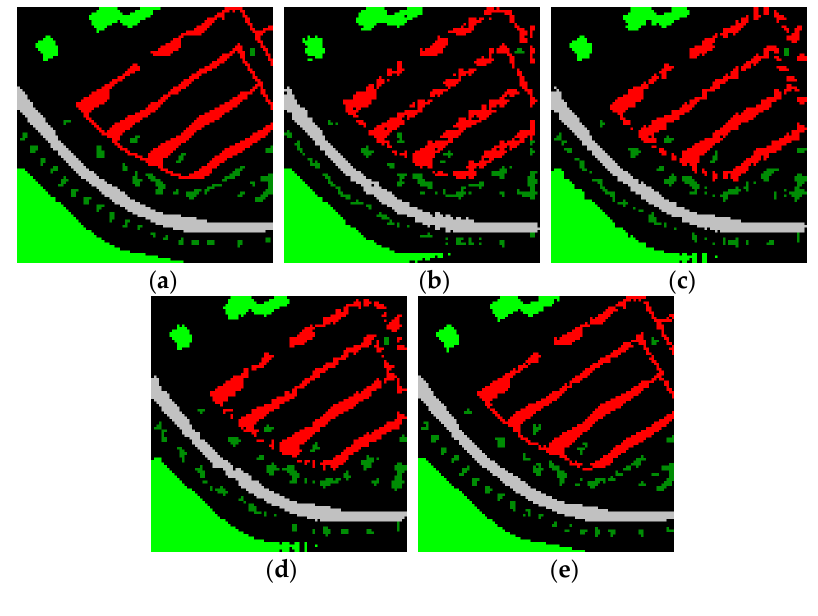
Figure 8. SRMSAM results in Experiment 1 ( S = 4). ( a ) Reference image. ( b ) Subpixel/pixel spatial attraction model (SPSAM). ( c ) Subpixel/subpixel spatial attraction model (MSPSAM). ( d ) Hybrid spatial attraction model (HSAM). ( e ) SRMSAM-PAN. Table 2. Mapping accuracy (%) of the four methods ( 4 S = ).